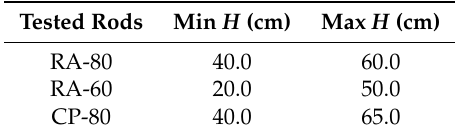
Table 4. Range of exposed length H of the rods in clayey